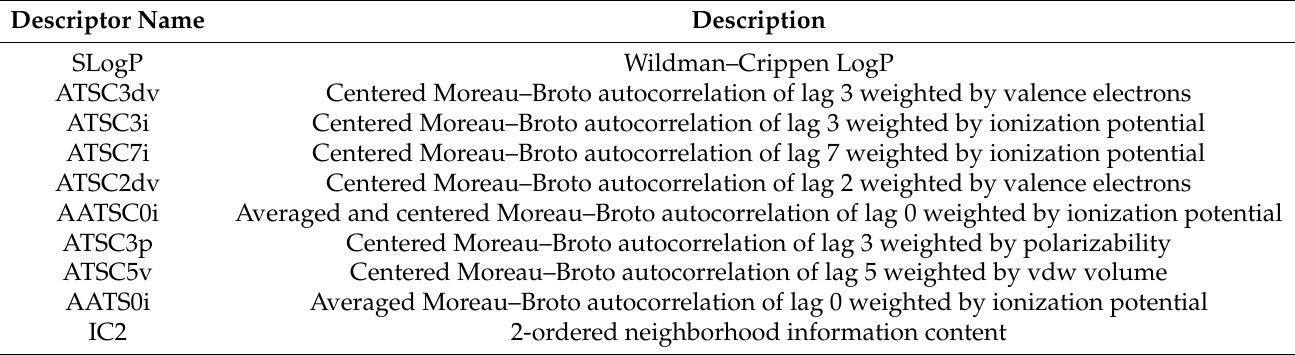
Figure 2. XGBoost-based feature importance graph from Mordred feature descriptors. Table 2. List of top ten Mordred descriptors with their brief